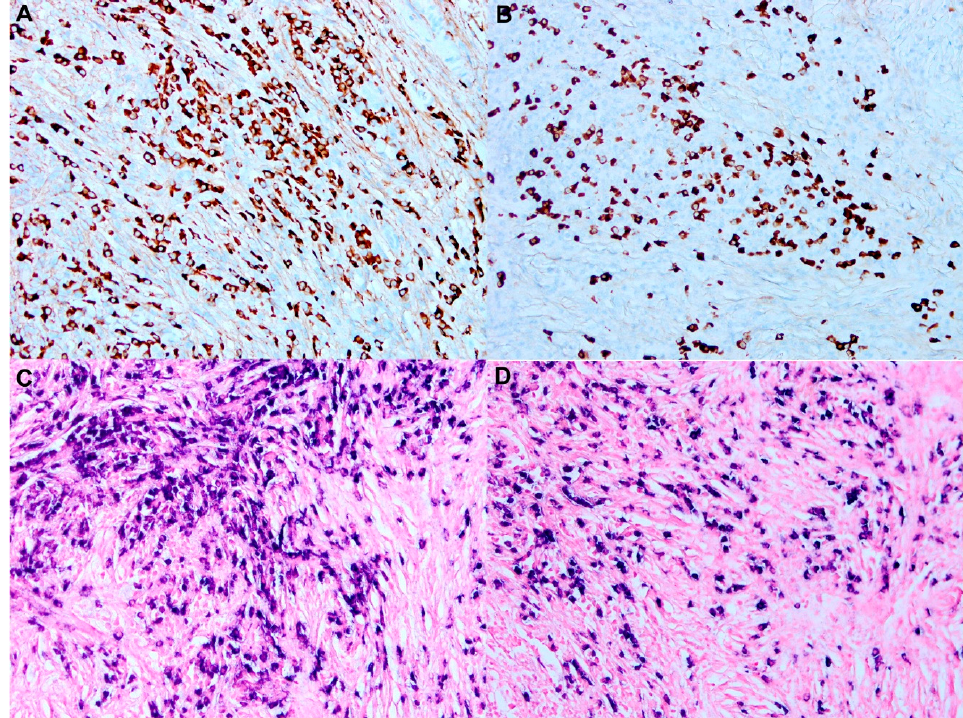
Figure 3. Representative images of IgG4 disease in a patient with Rosai–Dorfman disease (refer to Figure 1): increased plasma cells in a background of fibrosis. ( A , B ) Immunohistochemical stains demonstrate plasma cells positive for IgG and proportionally positive forIgG4 ( A , B ). immunoperoxidase 100×, respectively). ( C , D ) In situ hybridization using kappa and lambda light chain probes reveal the plasma cells to be polyclonal (in situ hybridization 100×, respectively).